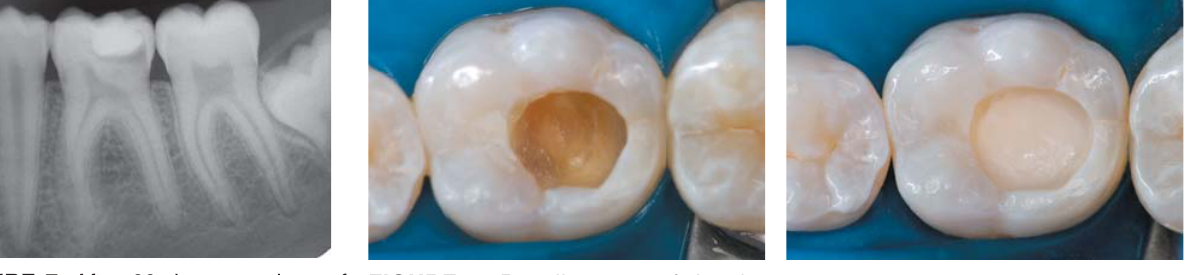
FIGURE 9- A resin-modified glass- FIGURE 8- Recall aspect of the